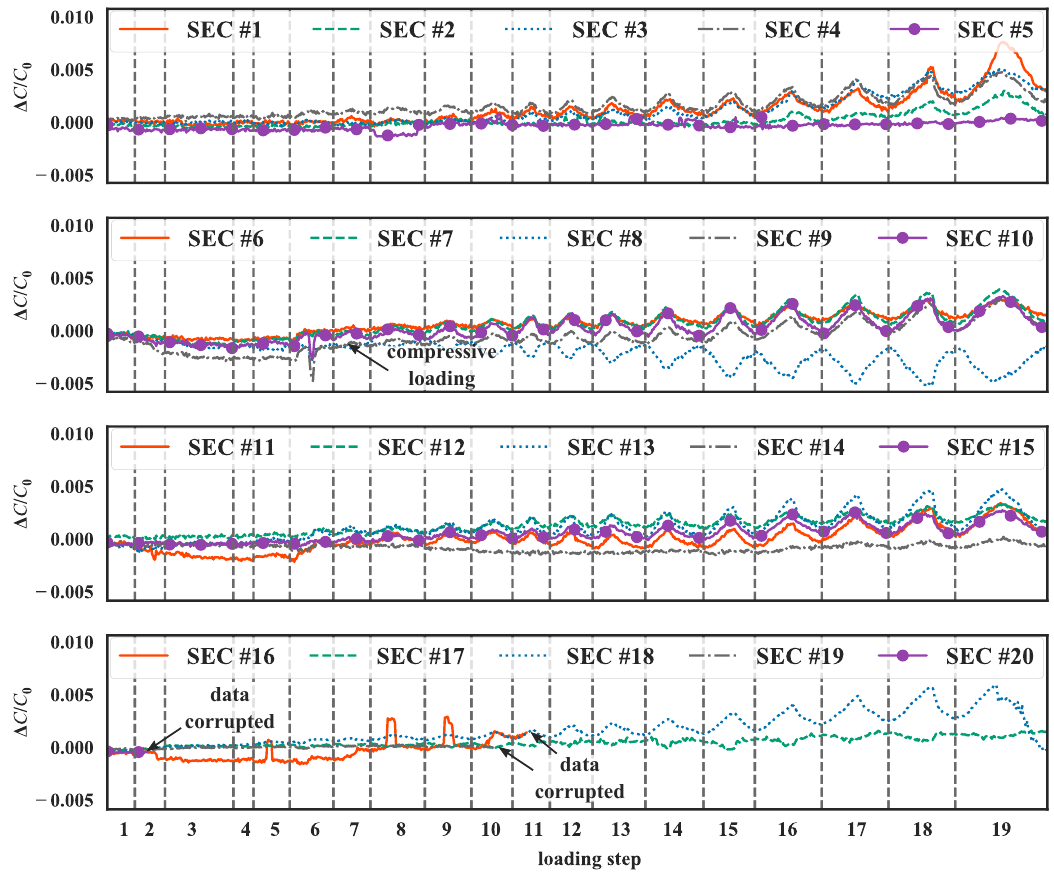
Figure 10. Time histories of strain measurements for all SECs.